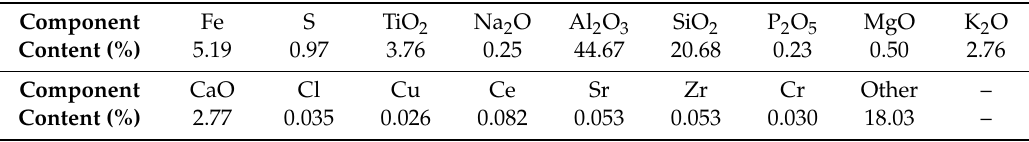
Table 1. Chemical analysis of the bauxite ore.